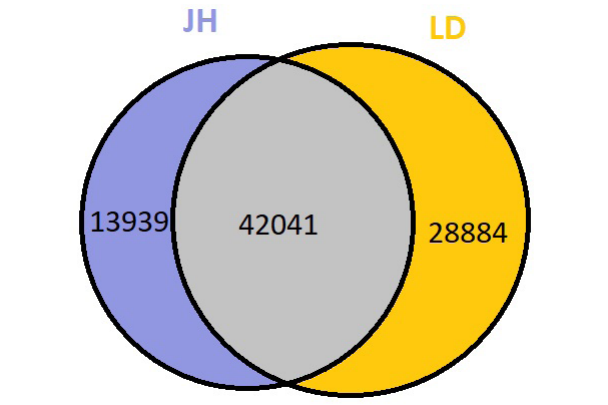
Figure 1. Identified circular RNA circular RNAs in the two pig breeds. JH, Jinhua; LD, Landrace.